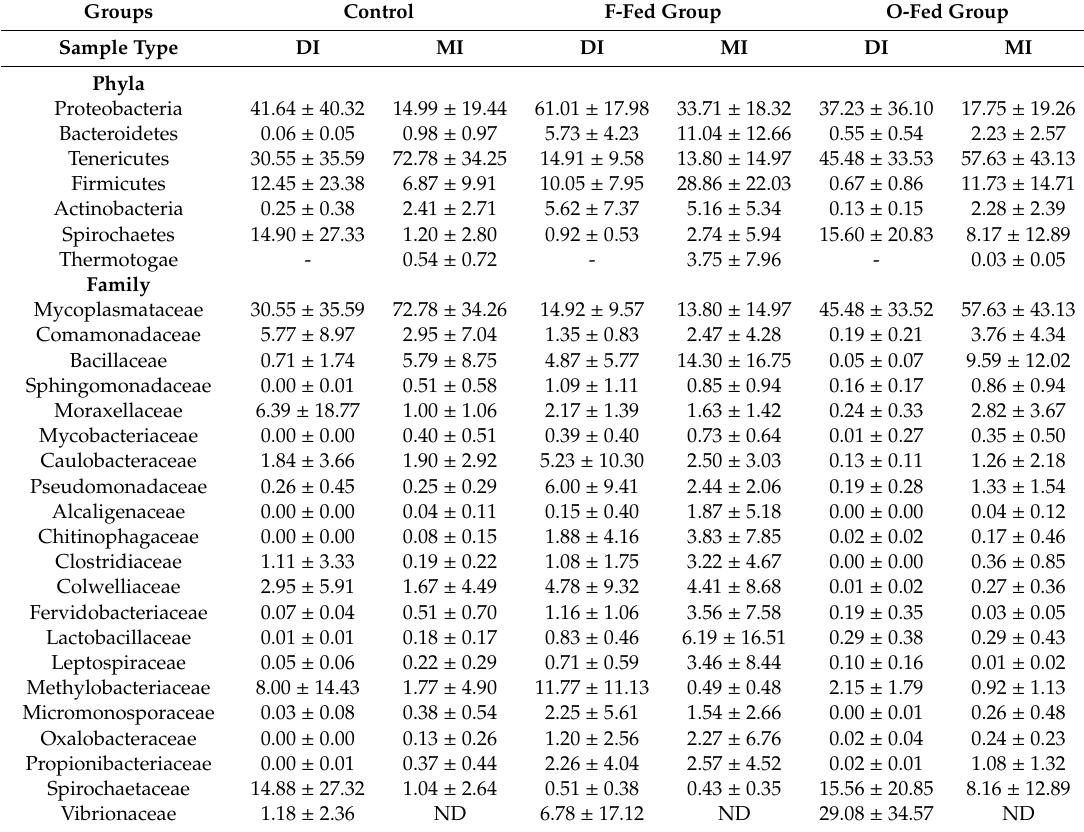
Table 2. Average relative abundance (%) of the dominant intestinal